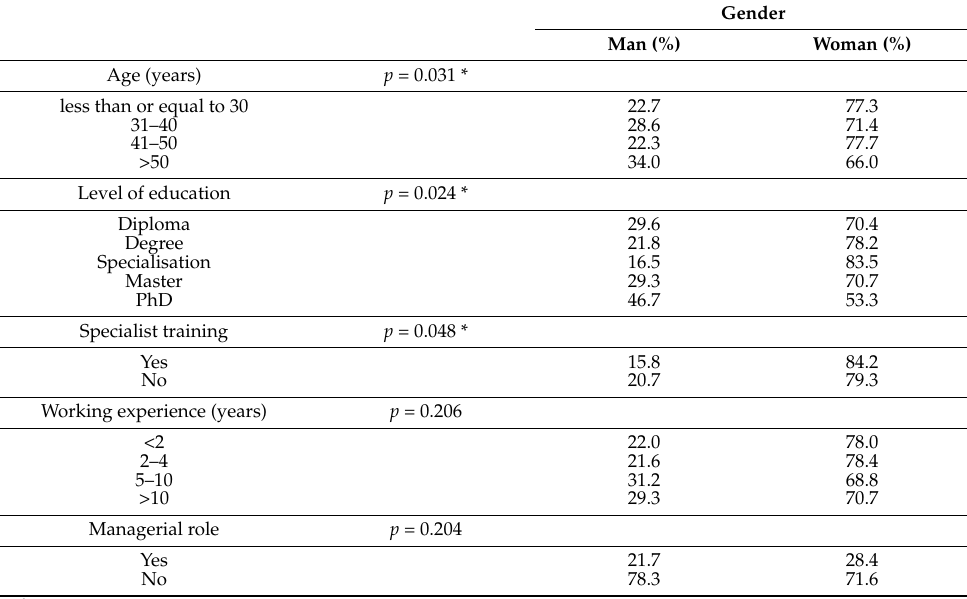
We investigated gender inequalities in our sample (Table 3). Our results show that most of the nurses were aged ≤ 50 years ( p = 0.031). The representation of women at higher education levels (masters or doctorate) is proportionally lower than that of men ( p = 0.024) but, paradoxically, women achieve a higher percentage of specialist training ( p = 0.048). Table 3. Distribution and comparison of socio-demographic and occupational data by